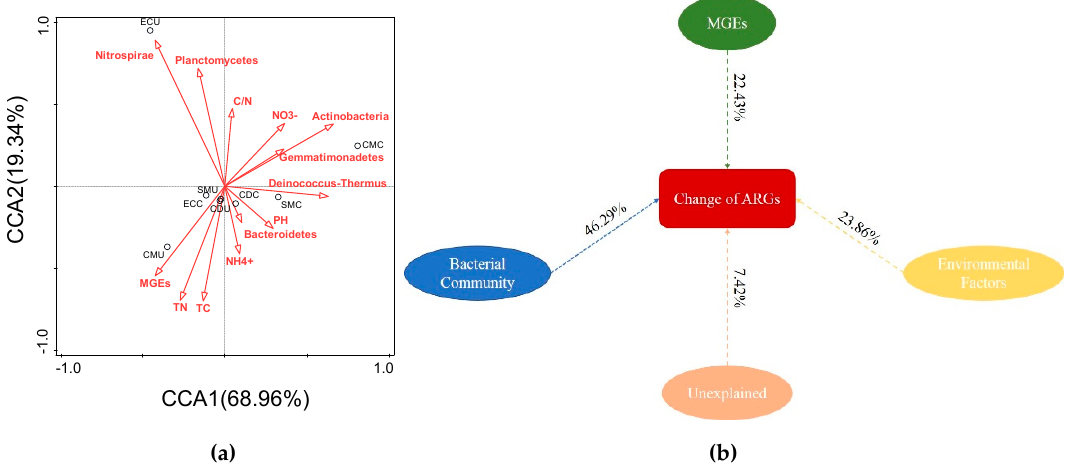
Figure 10. ( a ) Canonical correspondence analysis (CCA) illustrating relationships between microbial phyla, ARGs and environmental factors, including total nitrogen, total carbon, and pH. The percentage of variation explained by each axis is shown, and the relationship is significant ( p < 0.01) based on 999 permutations. ( b ) Variation partitioning analysis (VPA) di ff erentiates the e ff ects of bacterial communities, environmental factors, and mobile genetic elements (MGEs) on ARG profile alterations. TN: total nitrogen; TC: total organic carbon; and MGEs: mobile genetic elements.